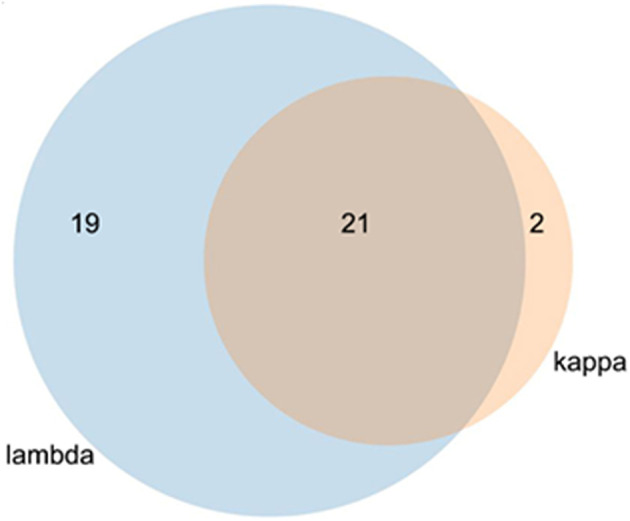
Venn diagram of kappa and lambda overlapping stains. The lambda light chain interacted with 40 individual proteins and the kappa LC with 23 proteins. Of the total of 42 proteins, 21 interacted with both LCs.